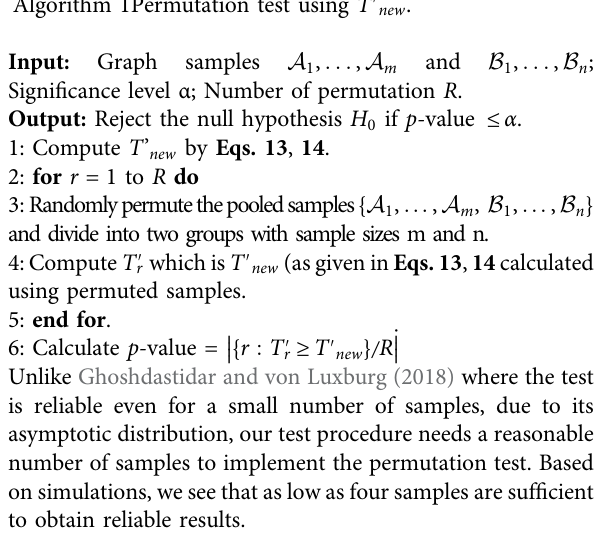
Algorithm 1Permutation test using T ′ new